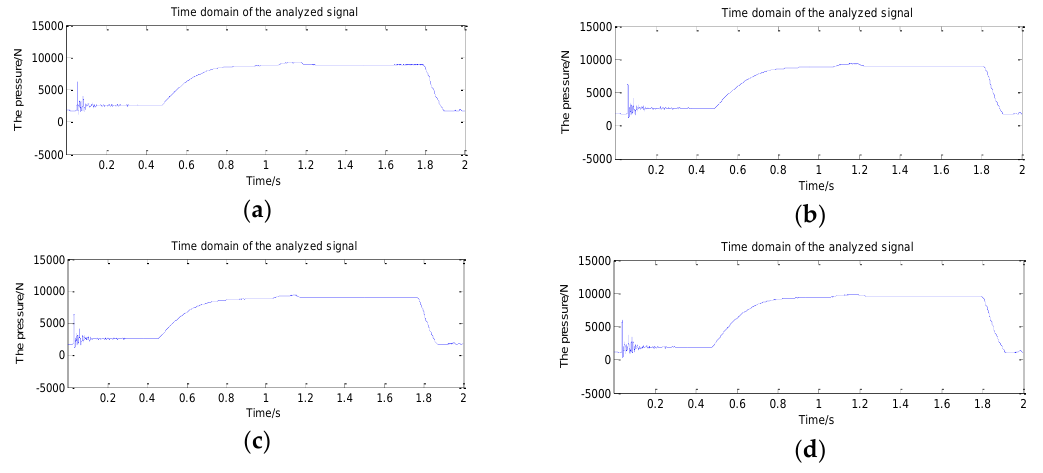
Figure 9. Time domain of the signal: ( a ) Data 11; ( b ) Data 12; ( c ) Data 13; ( d ) Data 20.